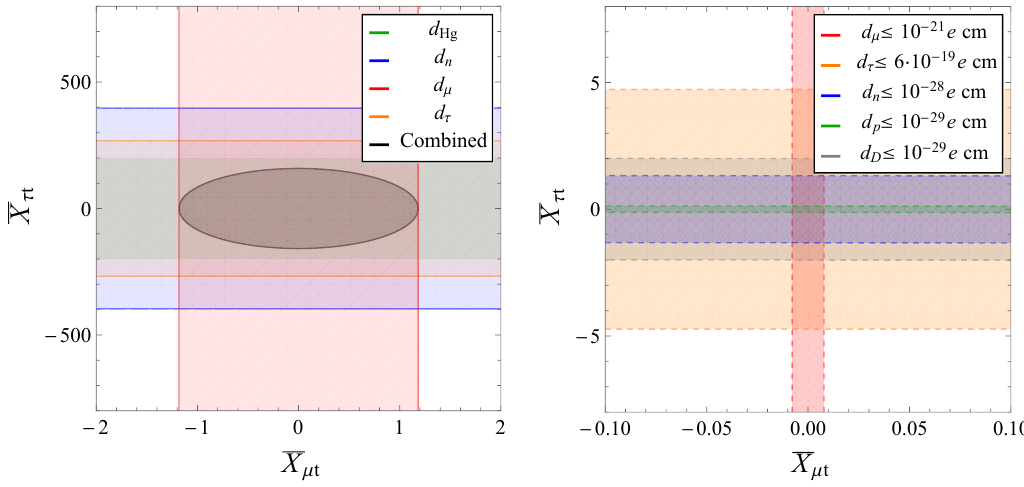
Figure 9 . Left panel: constraints from various EDM experiments in the (cid:22) X (cid:22)t - (cid:22) X (cid:28)t plane. The dark ellipse is the combined allowed region. Right panel: constraints using the expected sensitivities of prospected muon, neutron, proton, deuteron, and (cid:28) EDM